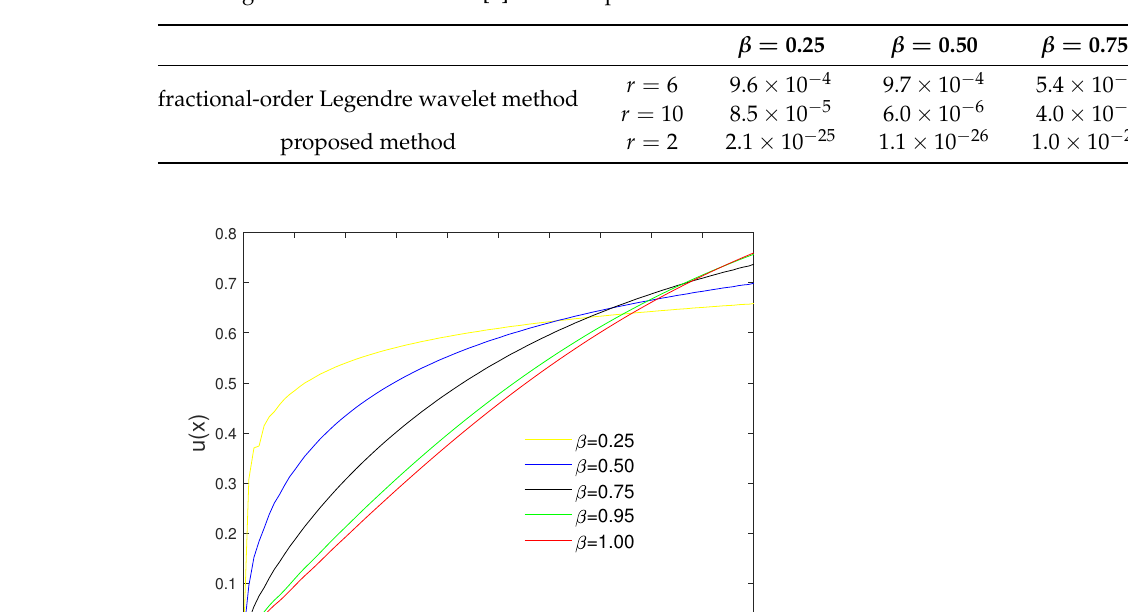
Table 3. Comparison of the absolute value of residual between the proposed method and fractional- order Legendre wavelet method [5] for Example 2.